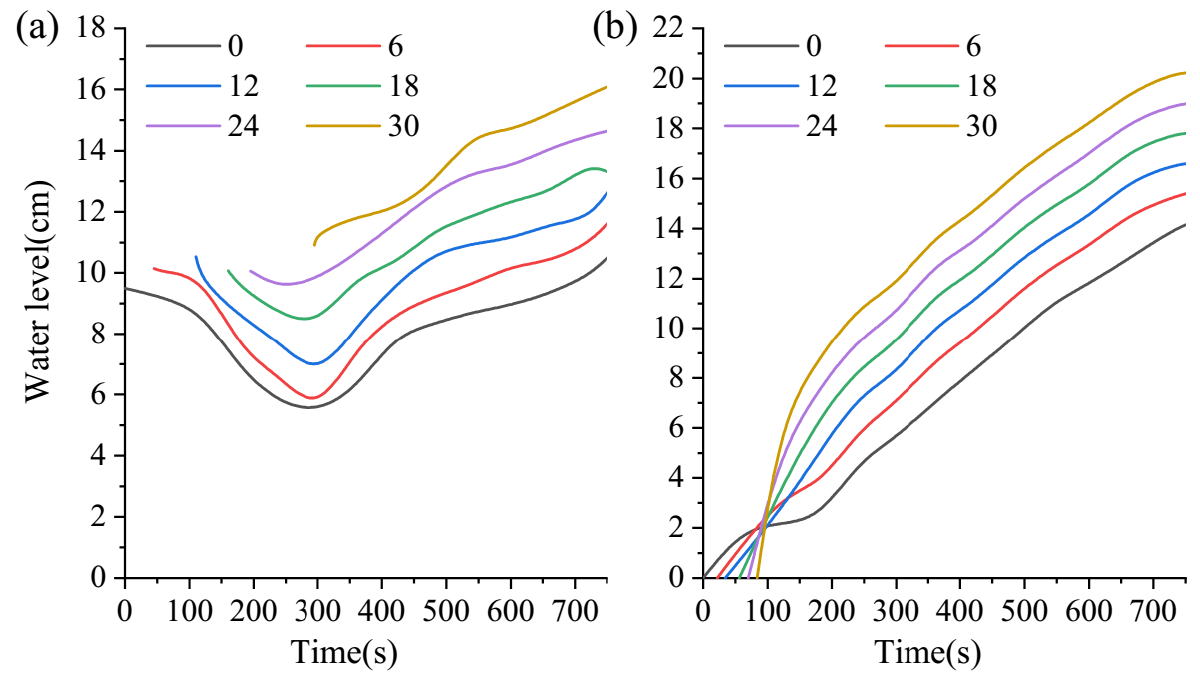
Figure 8. Changes in water level across different positions for ( a ) B2 and ( b ) B4.